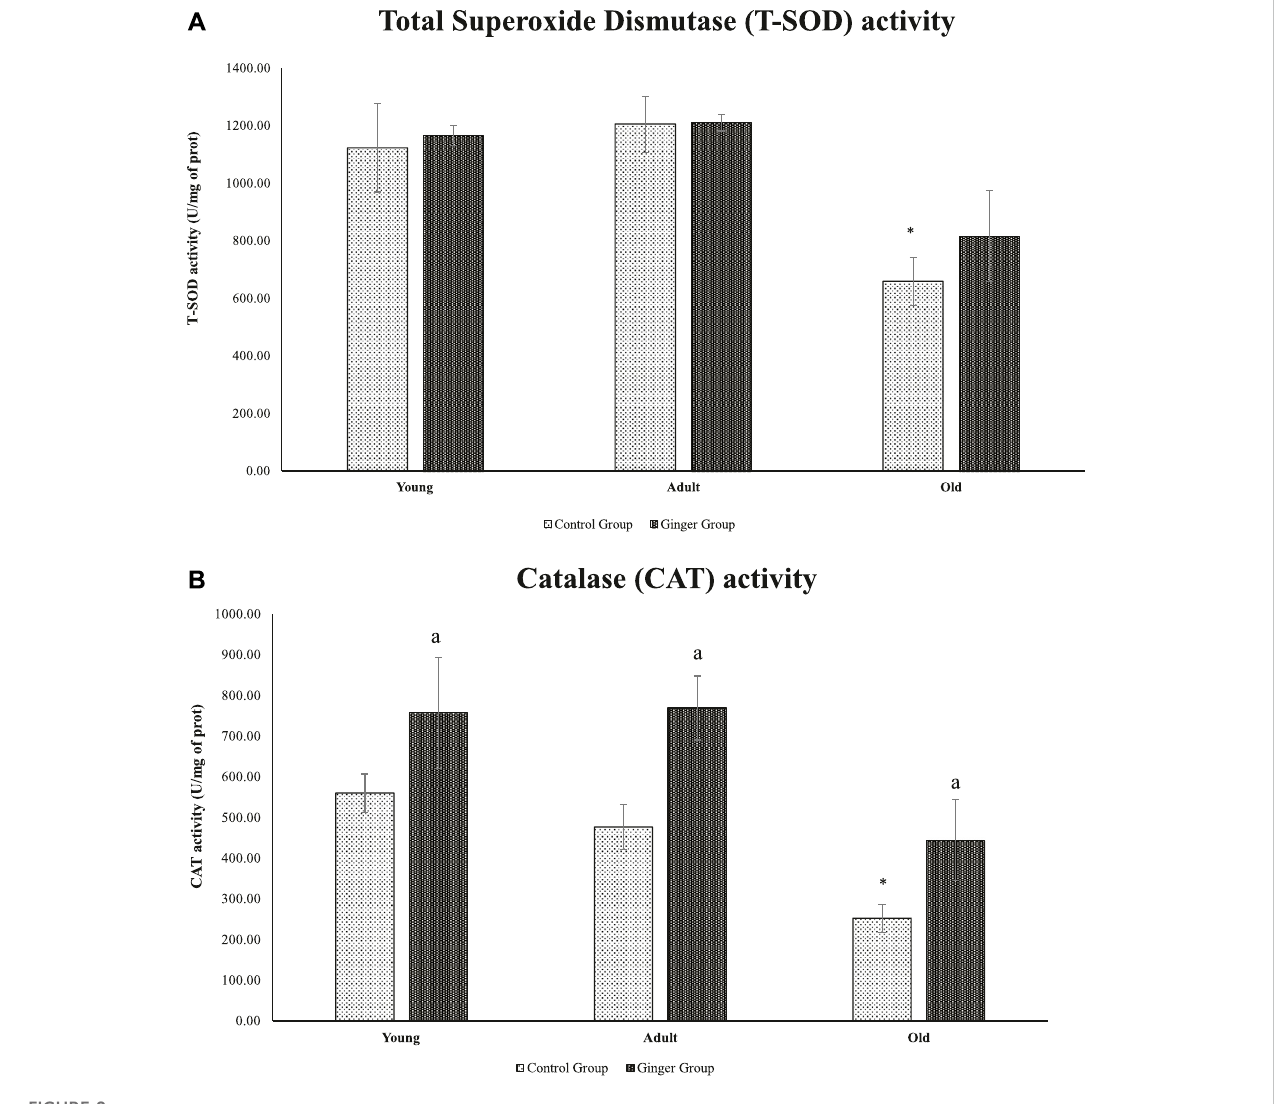
FIGURE 8 Age-related differences in T-SOD activity (A) and catalase activity of young, adult, and old rats (B) . The data was presented as mean ± SD, * p < .05 signi fi cantly different compared to young control rats, a p < .05 signi fi cantly different compared to untreated rats at respective